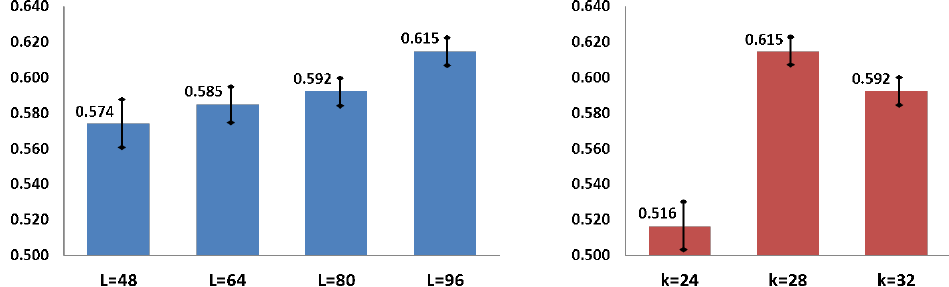
Figure 7. Validation results of the baseline method with different hyperparameter values. Y -axis shows the average recall (AR) score. ( left ) Results varying the training sequence length L . ( right ) Results varying the number of proposals k .